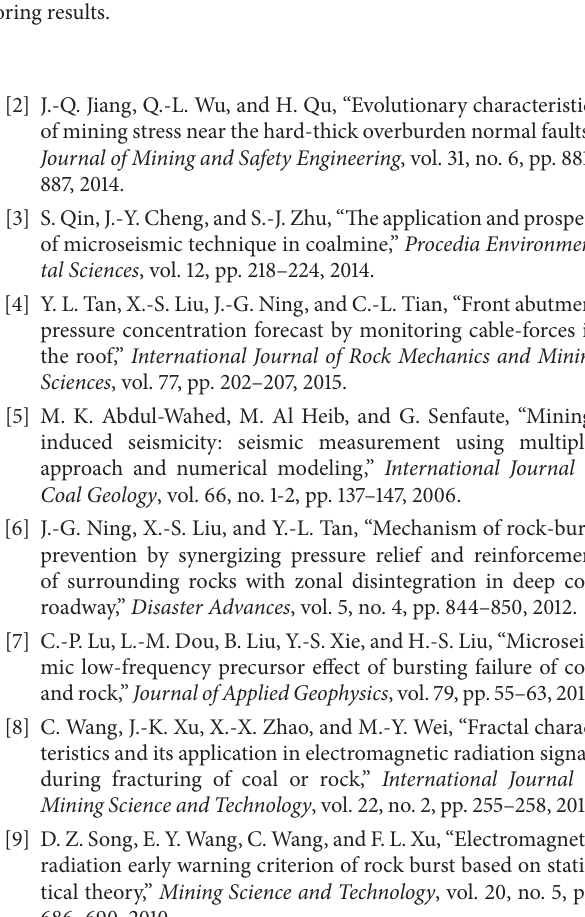
(c) The energy released by microseismic events Figure 8: Monitoring